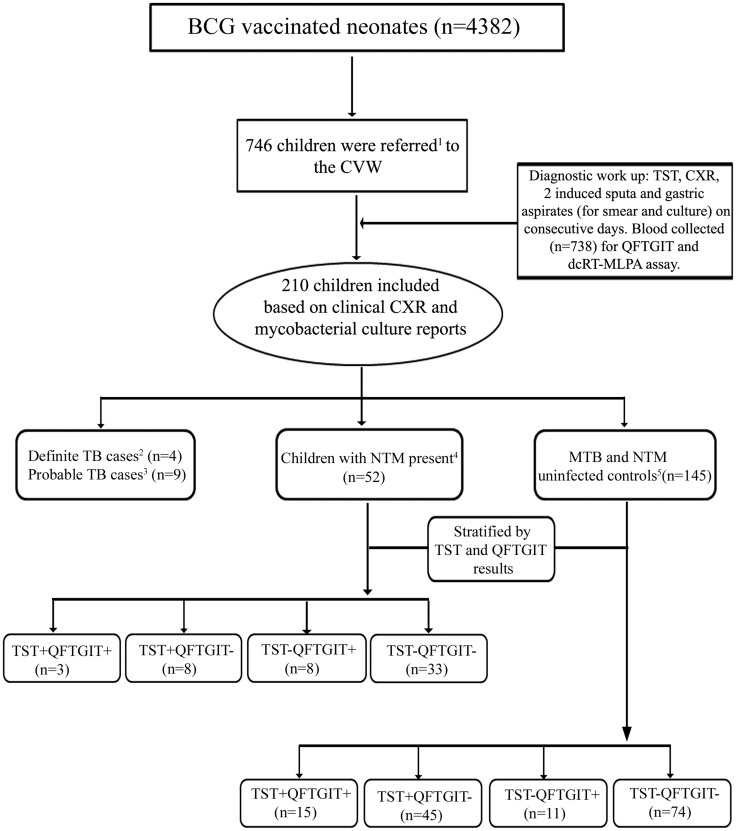
Flow chart of patients recruited to the study.
1Referral based on cough >2weeks, FTT, history of contact with a TB case and a TST ≥10 mm at study closure 2Abnormal CXR; MTB positive by the Hain MTB test or Roche test. 3Abnormal CXR; culture negative for MTB. 4Normal CXR; culture positive for NTM and 5Normal CXR; culture negative for MTB and NTM. Abbreviations: FTT – failure to thrive; CVW- case verification ward; CXR – chest X-ray; TST - tuberculin skin test; QFTGIT – QuantiFERON Gold In-tube test; dcRT-MLPA – dual colour reverse transcriptase – multiplex ligation dependent probe amplification; MTB – Mycobacterium tuberculosis; NTM – non-tuberculous mycobacteria.